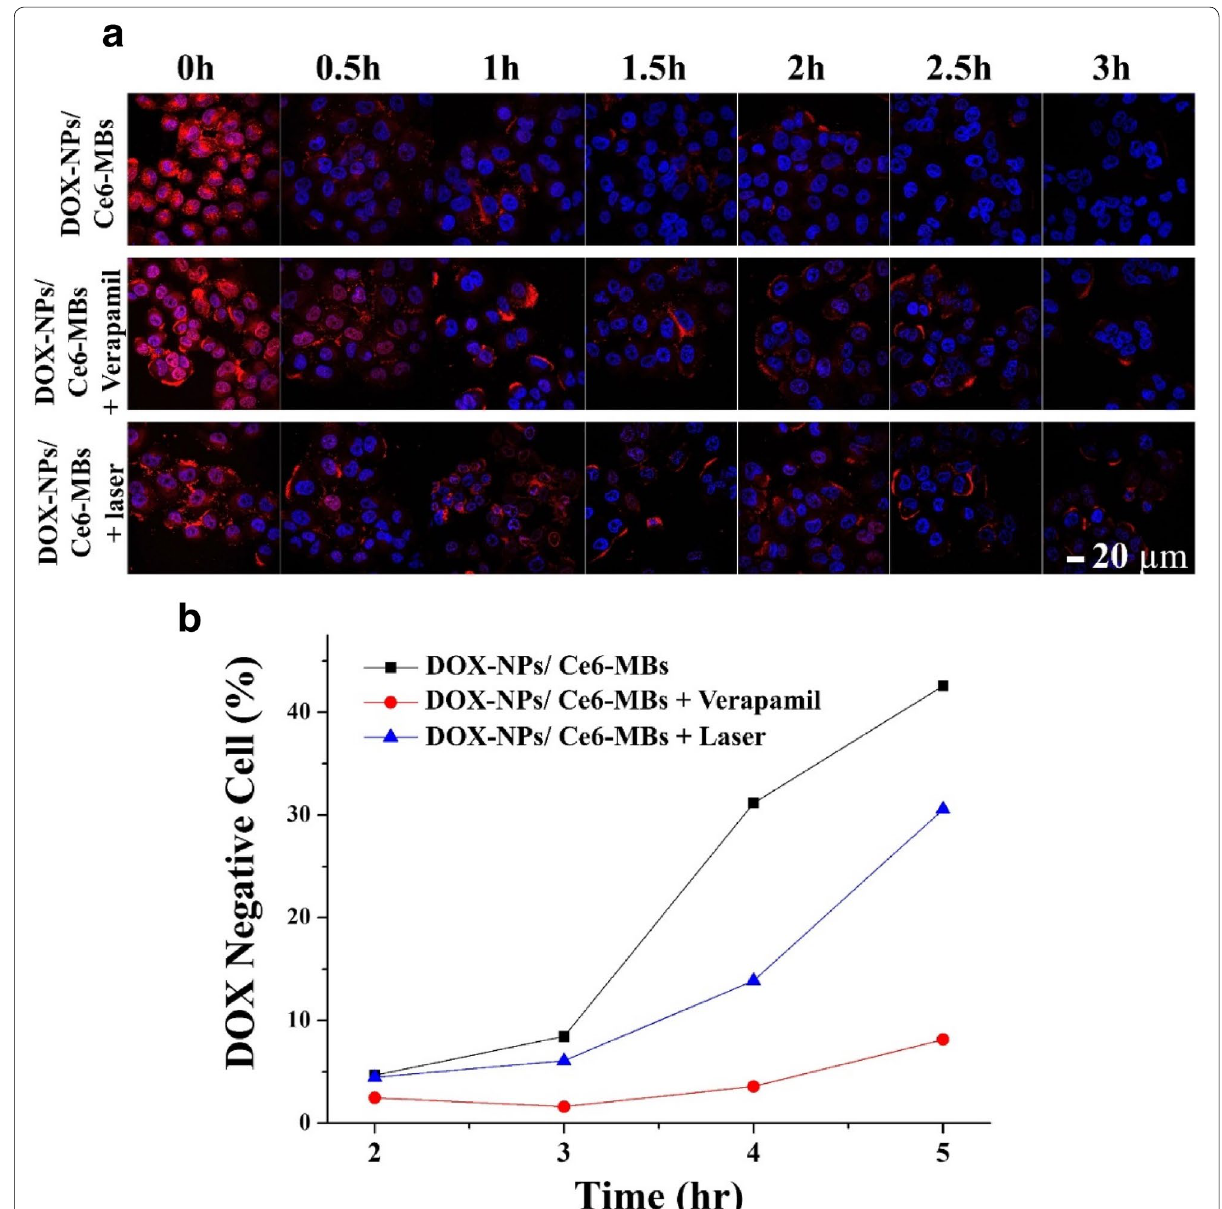
Fig. 5 Intracellular retention of DOX in MCF-7/ADR cells. a Fluorescence images showing DOX retention inside MCF-7/ADR cells after DOX-NPs/ Ce6-MBs treatment and subsequent US irradiation (0.2 W/cm 2 , 50% duty cycle, 30 s) every 30 min (scale bar cytometry data showing MCF-7/ADR cell percentages without DOX because of pumping